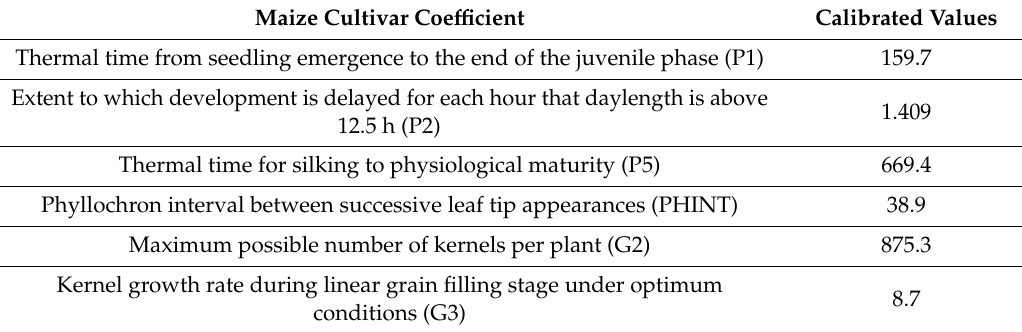
Table 3. Calibrated values of cultivar coefficients for CERES-Maize obtained using the generalized likelihood uncertainty estimation procedure in Decision Support System for Agrotechnology Transfer (DSSAT) v. 4.7.5.